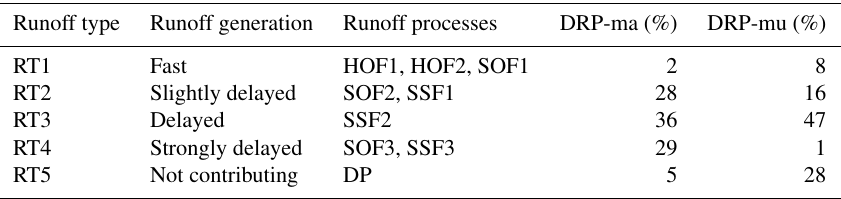
Table 2. Attribution of DRPs to RTs. Nomenclature of the DRPs is as follows: HOF is Hortonian overland flow, SOF is saturation overland flow, SSF is subsurface flow and DP is deep percolation. The suffix 1 is attributed to landscapes showing an immediate reaction in terms of runoff generation. The suffixes 2 and 3 denote delayed and strongly delayed reactions, respectively. Sources: Scherrer and Naef (2003) and Antonetti and Zappa (2018). The portion of RT in the maps of Margreth (DRP-ma) and Müller (DRP-mu) is given for the whole target area up to